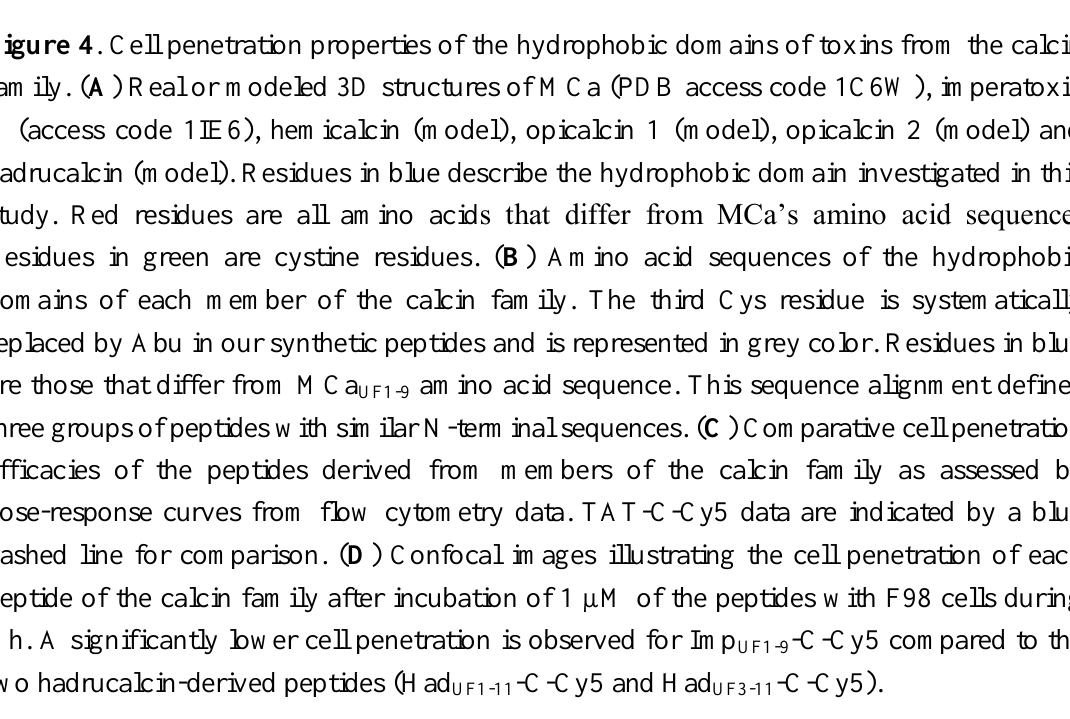
Figure 4 . Cell penetration properties of the hydrophobic domains of toxins from the calcin family. ( A ) Real or modeled 3D structures of MCa (PDB access code 1C6W), imperatoxin A (access code 1IE6), hemicalcin (model), opicalcin 1 (model), opicalcin 2 (model)